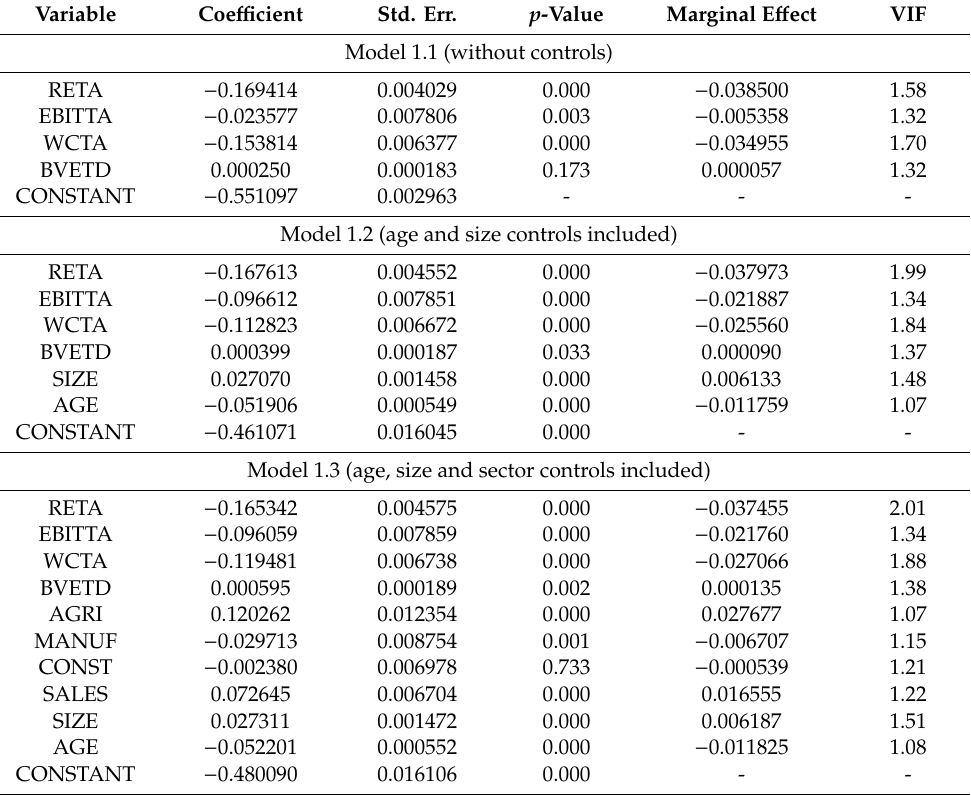
Table 3. Three logistic regression models with financial ratios as independent variables (dependent variable